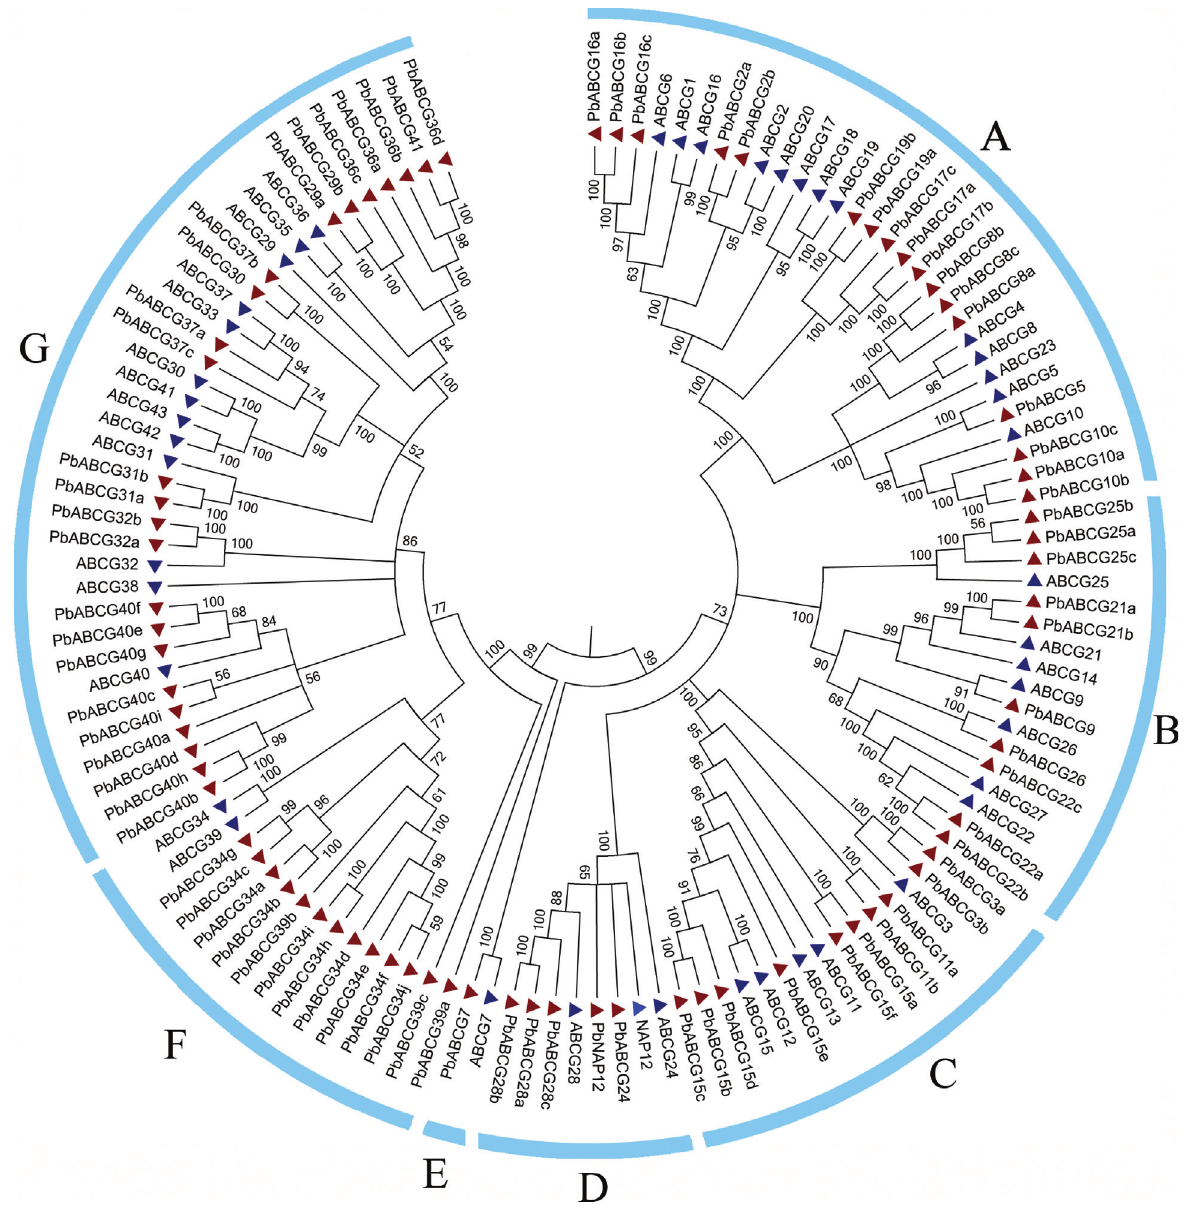
Figure 1 - Phylogenetic tree of ABCG genes in pear and Arabidosis annotated with collinear and tandem relationships. The genes are divided into seven groups from A to